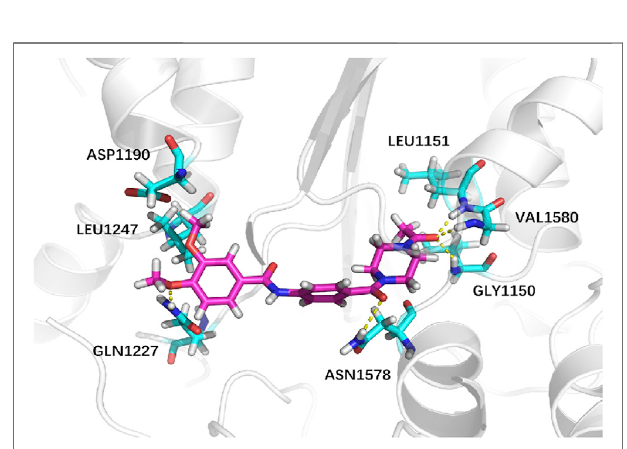
FIGURE 4 | Predicted mode of iDNMT/DNMT-1